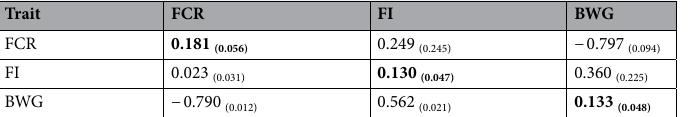
Table 2. Heritability estimates (bold, diagonal), genetic correlations (above diagonal) and phenotypic correlations (below diagonal) for feed conversion ratio (FCR), feed intake (FI) and body weight gain (BWG). Standard errors are in